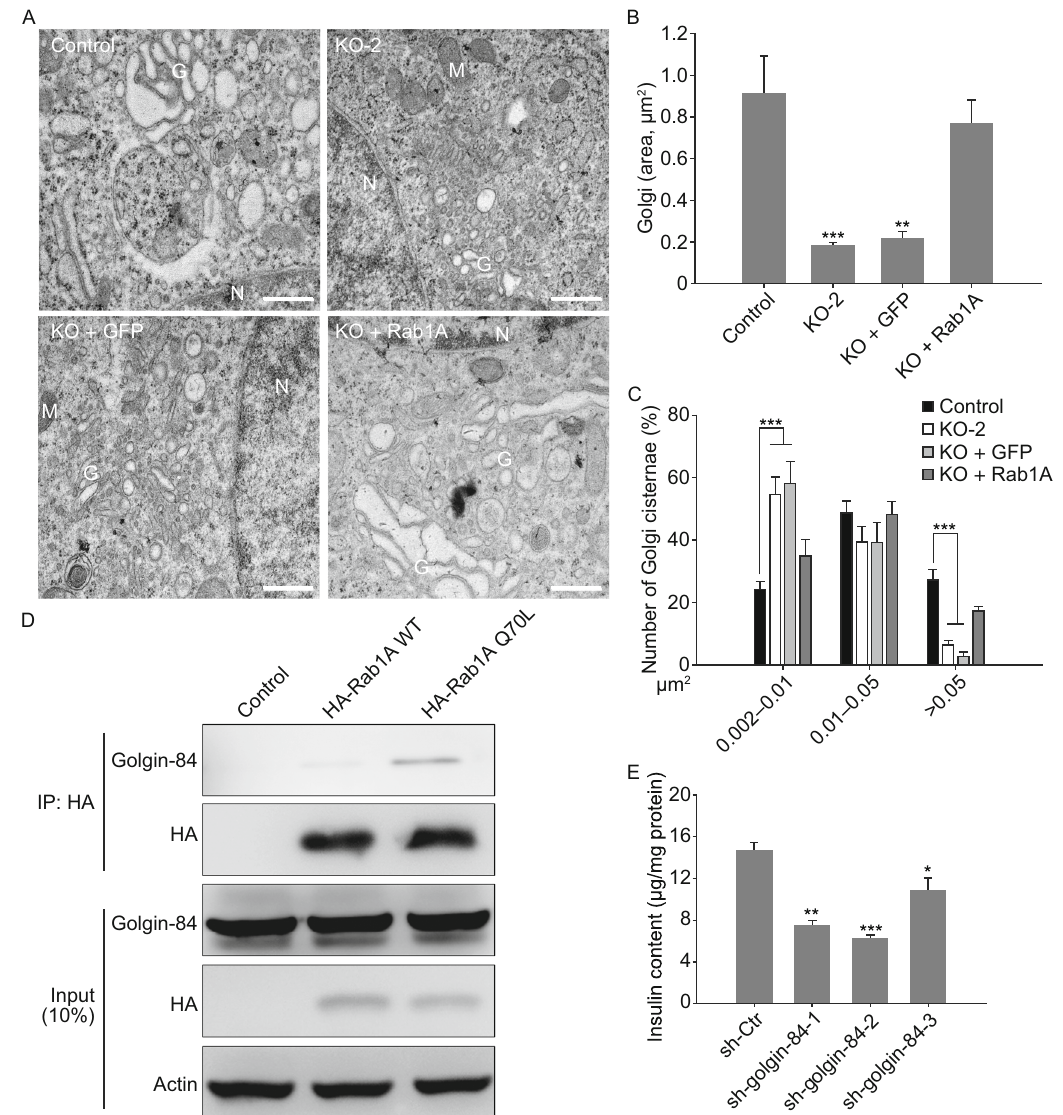
Figure 2. Rab1a knockout results in Golgi ribbon fragmentation . (A) Electron micrograph of the cells as described in Fig. 1B (G, Golgi; M, mitochondria; N, nucleus). All images are presented at 21,000× magni fi cation. Scale bars, 0.5 μ m. (B and C) Golgi (B) and Golgi cisternae (C) areas in the electron micrographic images were measured using Image Pro Plus (numbers of measured cells: Control, n = 21; KO-2, n = 20; KO + GFP, n = 14; KO + Rab1A, n = 14). (D) Immunoprecipitation of Rab1A interaction proteins by anti- HA antibody and analyzed with anti-golgin-84 antibody by Western blotting. IP: immunoprecipitation. (E) Insulin content in golgin-84 shRNAs infected INS-1E cells was determined. The results are presented as the mean ± S.E.M. ( n = 3). *, P < 0.05; **, P < 0.01; *** P <